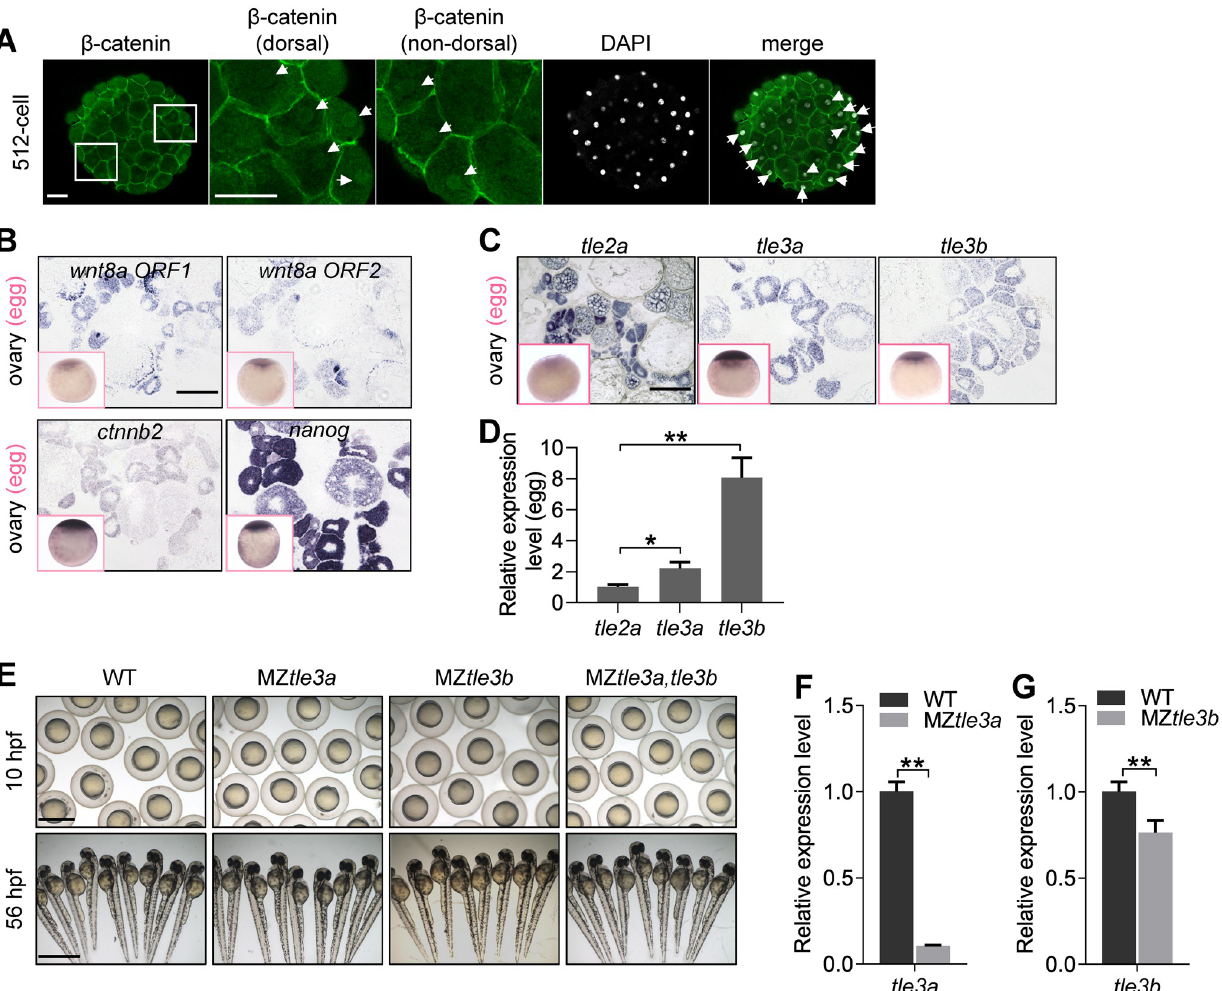
Fig 1. Maternal TLEs do not likely contribute to the repression of maternal β -catenin activity. (A) Detection of nuclear localization of maternal β - catenin in embryo at 512-cell stage by immunostainning against β -catenin. Signals were observed at animal view. Nuclei were co-stained with DAPI. Arrow heads indicate the nuclear accumulation of β -catenin. Scale bar, 50 μ m. (B) In situ hybridization on cryosections of ovaries and WISH on unfertilized eggs (pink framed squares) showing wnt8a1 , wnt8a2 , ctnnb2 , and nanog are maternally expressed during oogenesis and in unfertilized eggs. Scale bar, 100 μ m. (C) In situ hybridization on cryosections of ovaries and WISH analysis of unfertilized eggs (pink framed squares) showing tle2a , tle3a , and tle3b are maternally expressed during oogenesis and in unfertilized eggs. Scale bar, 100 μ m. (D) In comparison with tle2a , tle3a , and tle3b are significantly highly expressed in matured eggs as shown by RT-qPCR analysis. Error bars, mean ± SD, � P < 0.05, �� P < 0.01. (E) The maternal -zygotic mutant of tle3a (MZ tle3a ) or tle3b (MZ tle3b ), or double mutant of tle3a and tle3b (MZ tle3a , tle3b ), showed no early developmental defect. Scale bar, 1 mm. (F) RT-qPCR analysis showing mRNA expression level of tle3a was significantly reduced in MZ tle3a at 3 hpf. Error bars, mean ± SD, �� P < 0.01. (G) RT-qPCR analysis showing mRNA expression level of tle3b was significantly reduced in MZ tle3b at 3 hpf. Error bars, mean ± SD, �� P < 0.01. The P values in this figure were calculated by Student t test. The underlying data in this figure can be found in S1 Data. hpf, hours post fertilization; MZ tle3a , maternal -zygotic mutant